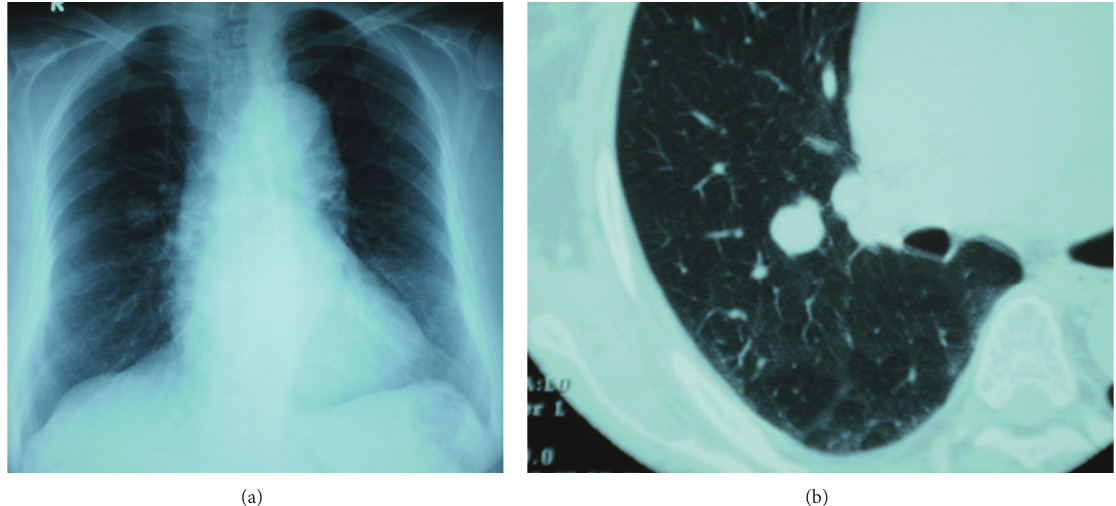
Figure 1: (a) Simple chest X-ray indicated a coin lesion on the middle field of the right lung. (b) Simple chest computed tomography revealed a nodule measuring 20mm in diameter and having a well-defined border in S2 of the right lung.